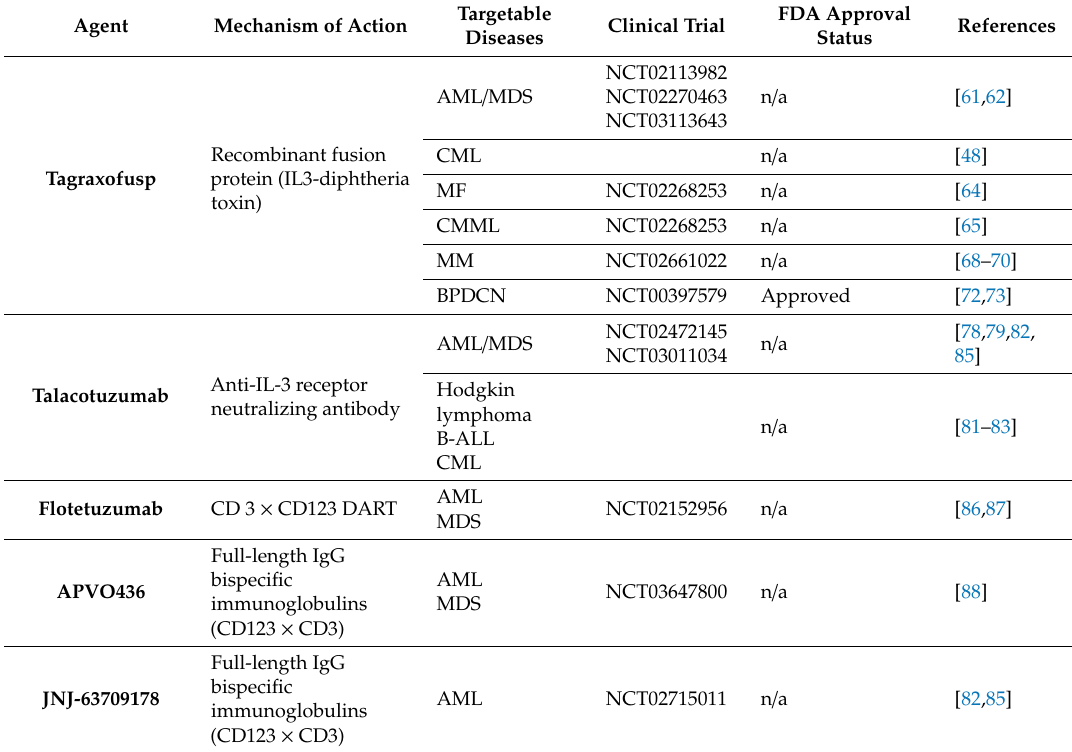
Table 1. Current agents and clinical trials exploring CD123 as a marker for targeted